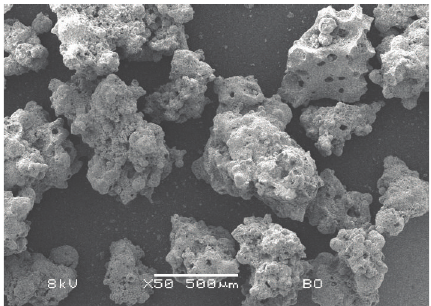
Table 1: Physical and chemical properties of materials. Table 2: Mix proportions of cellular concrete.